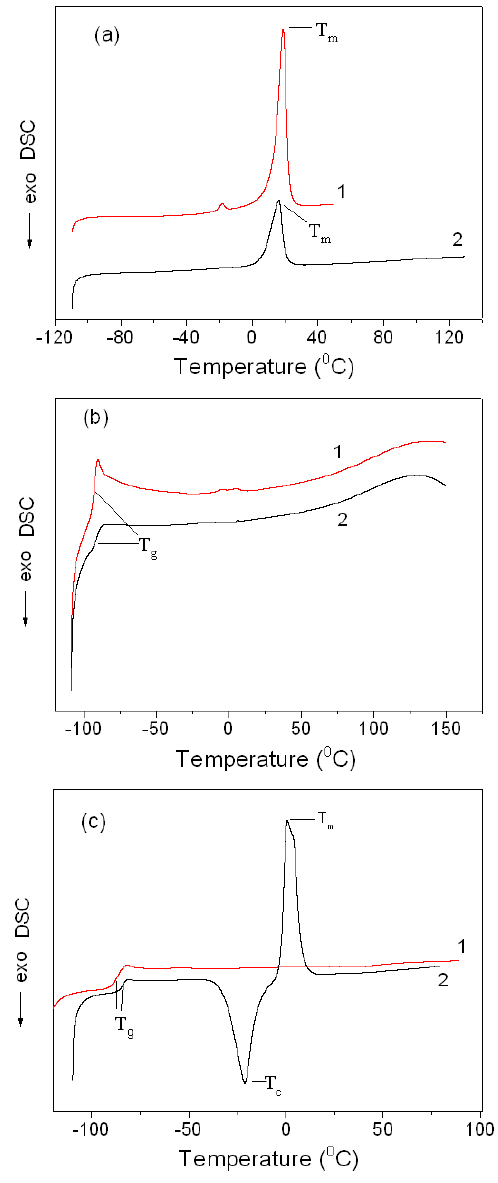
Figure 6. Di ff erential scanning calorimetry (DSC) curves of the second heating cycle ( a ) 1: BMImOTf, 2: MMT K10 / BMImOTf; ( b ) 1: BMImNTf 2 , 2: MMT K10 / BMImNTf 2 ; ( c ) 1: BMImDCA, 2: MMT K10 / BMImDCA.